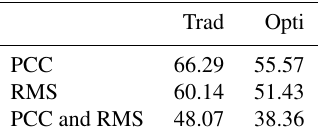
Figure 6. Time series of PCC and RMS for August 2016. Opti is the optimized tomography-derived water vapor density, and Trad is the traditional tomography-derived water vapor density. Table 6. Statistical results of PCC and RMS for August 2016